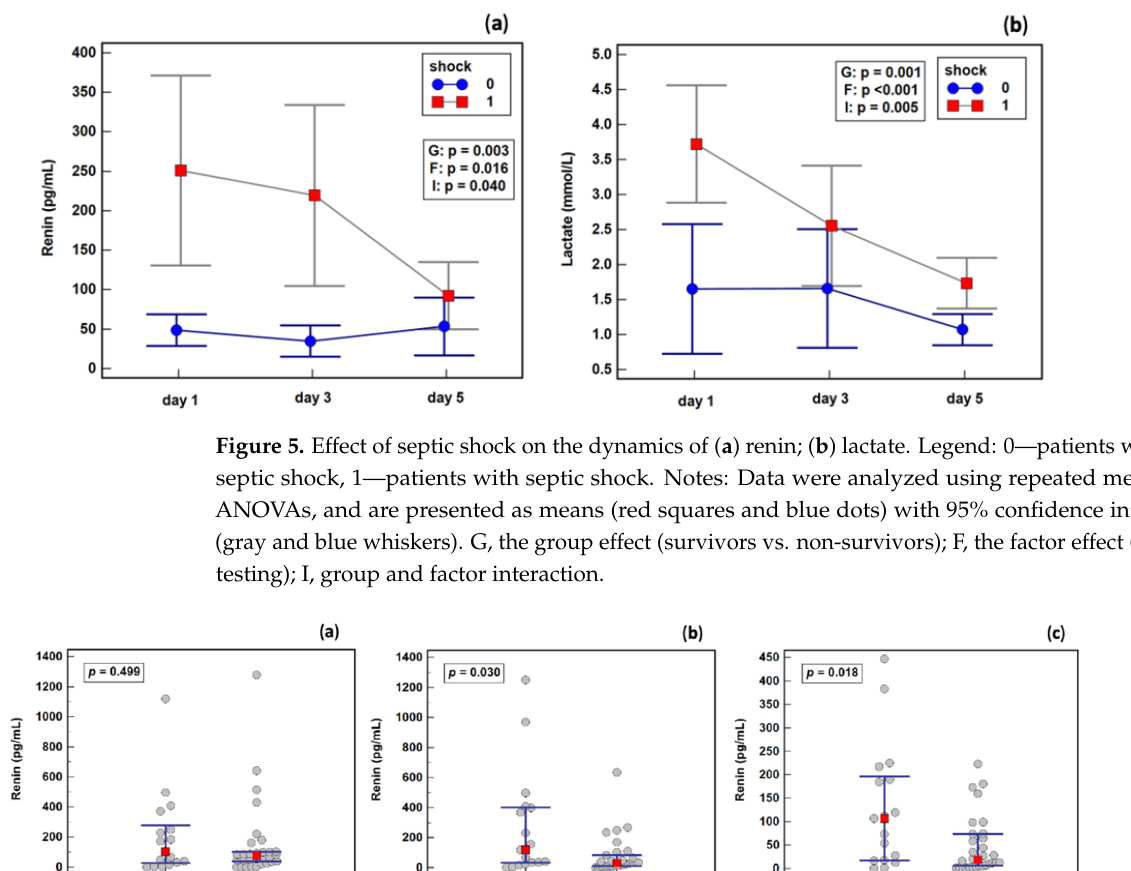
Figure 6. Renin concentration in sepsis survivors and non-survivors: ( a ) on the first study day; ( b ) the third study day; ( c ) in the fifth study day. Legend: 0—non-survivors, 1—survivors. Notes: Data were analyzed using Mann–Whitney U tests, and are presented as medians (red squares) with in- terquartile ranges (blue whiskers).